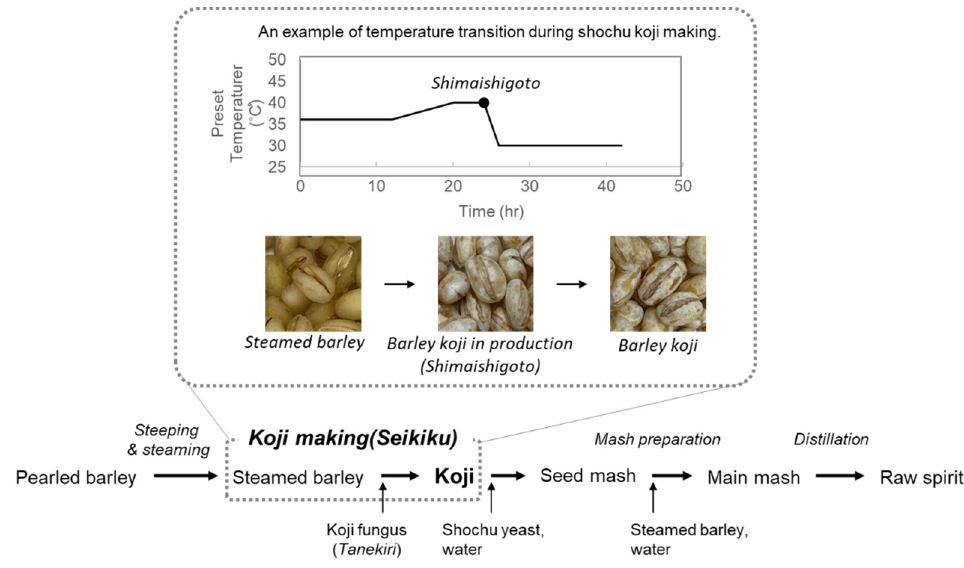
Figure 1. Making method for single distilled barley shochu.